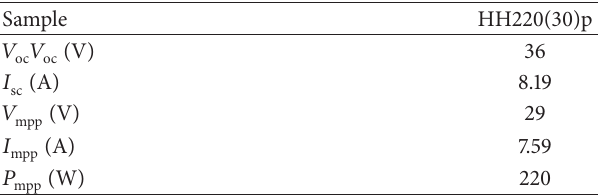
Table 3: Key parameters of the PV module under STC.